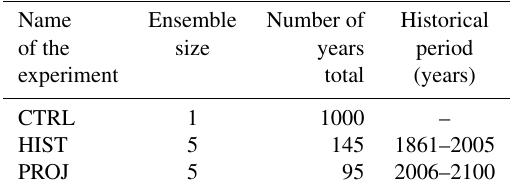
Table 1. Abbreviation names for the CM2.5 experiments.